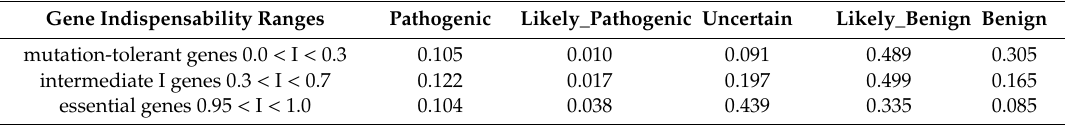
Table 4. Proportions of predicted pathogenicity classes for three gene indispensability ranges. Gene Indispensability Ranges